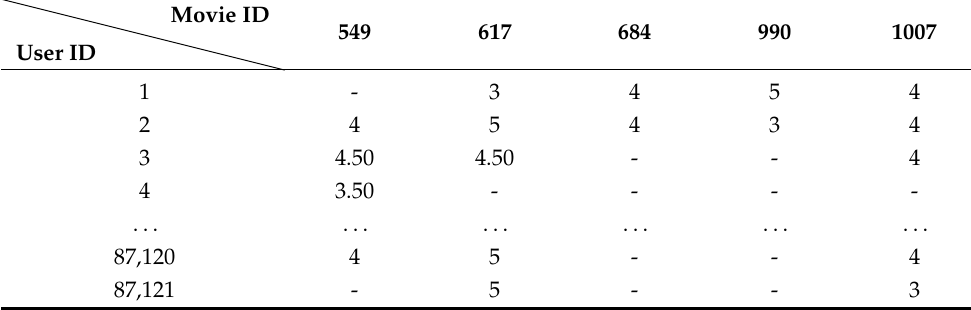
Table 3. The structure and parameter settings for the NNCF predictor. Name Value Number of nodes for users and movies in the input layer (87,122, 12,474) Number of nodes for users and movies in the embedding layer (32, 32) Number of hidden layers in the MLP 2 Number of nodes in the hidden layers of the MLP (50, 10) Batch size 200 Loss function Mean squared error